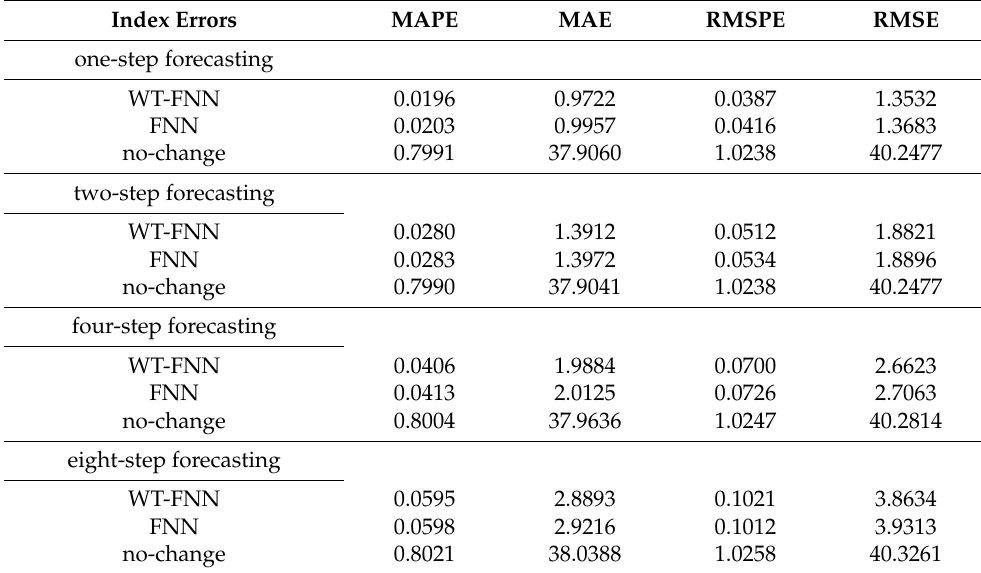
Table 5. Comparisons of predictions from different forecasting models with different